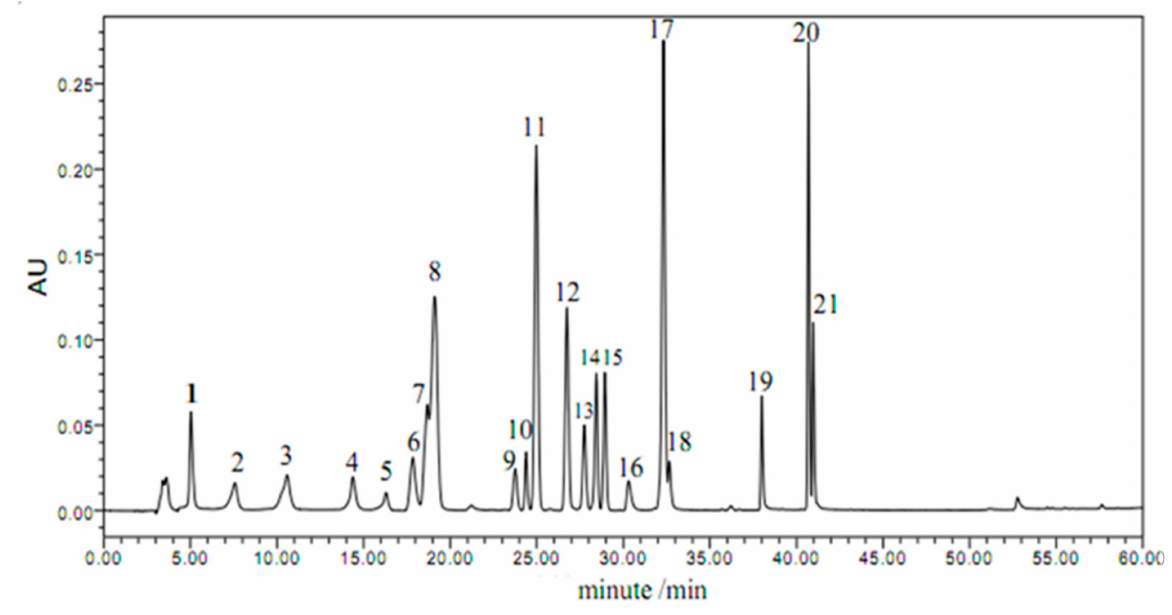
Figure 1. HPLC chromatogram of standards of phenolic compounds. (1) Phloroglucinol; (2) gallic acid; (3) protocatechuic acid; (4) chlorogenic acid; (5) catechin; (6) 2, 4-Dihydroxybenzoic acid; (7) vanillic; (8) syringic acid; (9) p-coumaric; (10) rutin; (11) ferulic acid; (12) salicylic acid; (13) naringin; (14) hesperidin; (15) benzoic acid; (16) o-coumaric acid; (17) myricetin; (18) quercetin; (19) 3, 4-Dimethoxybenzoic acid; (20) naringenin; (21)